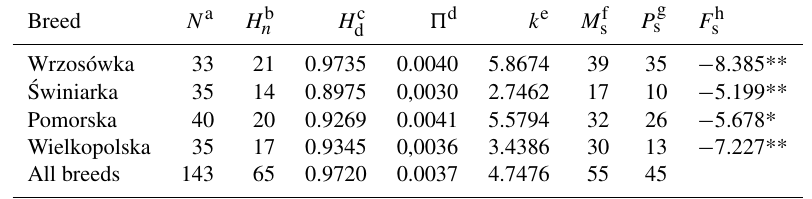
Table 3. Genetic diversity parameters and Fu’s F statistics in analysed sheep. Breed N a H b n H c